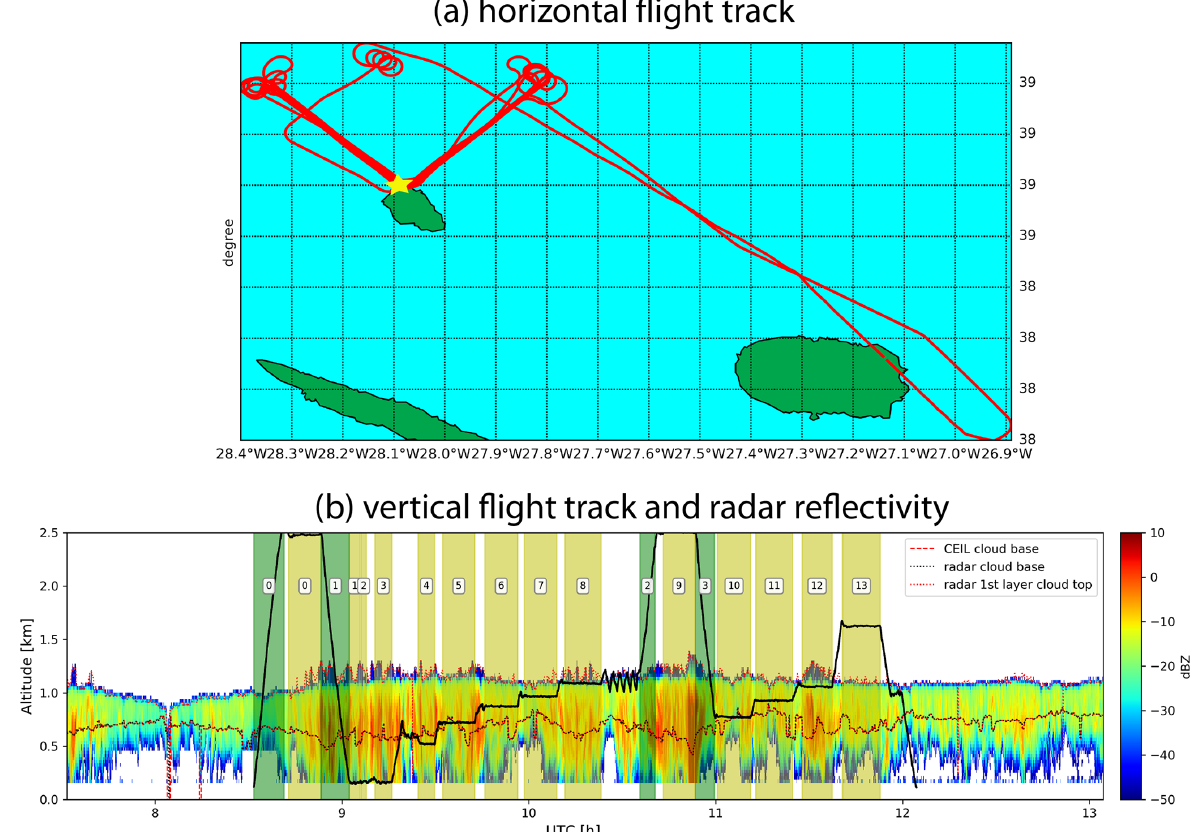
Figure 1. (a) Horizontal flight track of the G-1 aircraft (red) during the 18 July 2017 RF around the DOE ENA site (yellow star) on Graciosa Island. (b) The vertical flight track of G-1 (thick black line) overlaid on the radar reflectivity contour by the ground-based KZAR. The dotted lines in the figure indicate the cloud base and top retrievals from ground-based radar and CEIL instruments. The yellow-shaded regions are the “hlegs” and green-shaded regions are the “vlegs”. See text for their